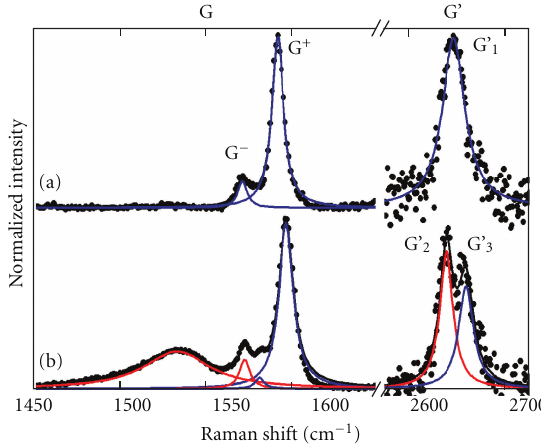
Figure 4: Raman spectroscopy analysis of one SWNT grown on quartz. Spectrum (a) exhibits a G band with a line shape typical of a semiconducting SWNT. Spectrum (b) exhibits a G band showing a mixture of lineshapes typical of semiconducting (blue Lorentzians) and a metallic (red Lorentzians) SWNT behavior. Note that the G (cid:3) peak splits in (b) (adapted from